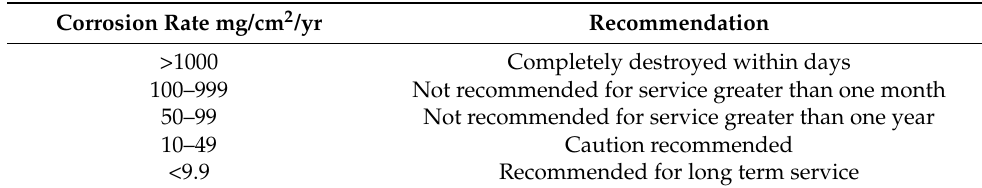
Table 5. Guide for interpretation of corrosions rates used in literature (based on [30]).